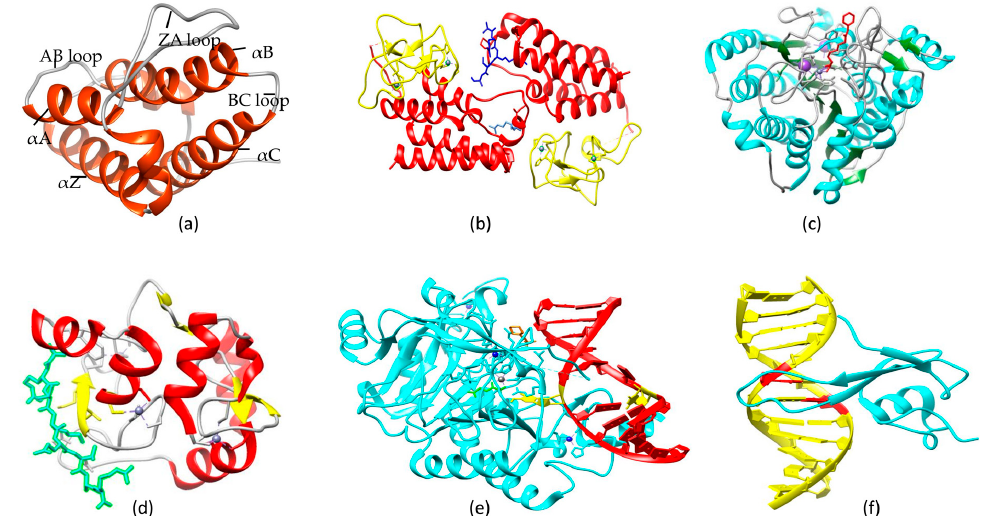
Figure 4. Structure and complexes of epigenetic proteins. ( a ) Structure of SP100 (Speckled 100 kDa): the hydrophobic cavity formed by helices can accommodate histone sequences (PDB ID: 4PTB) (orange = helices, gray = loops); ( b ) Crystal structure of TRIM24 PHD-BRD complexed with H3K27 acetylated peptide (PDB ID: 3O35) (yellow = PHD, red = bromodomain, blue = H3K4ac, cornflower blue = H3K27ac, dark gray = zinc (II) ions ( c ) Crystal structure of HDAC-like protein (Chain A) bound to SAHA (PDB ID: 1ZZ1) (red = SAHA, dark gray ball = Zinc, purple ball = potassium); ( d ) Crystal structure of DNMT3A ADD domain (Chain C) bound to H3 peptide (PDB ID: 4QBQ) (cyan = H3 peptide, dark grey = zinc); ( e ) Crystal structure of TET2 protein in complex with 5hmC (PDB ID: 5DEU) (cyan = TET2, red = DNA, yellow = 2 ′ -deoxy-5-(hydroxymethyl) cytidine 5 ′ -(dihydrogen phosphate), dim gray ball = Fe (III) ion, orange = 2-( n -morpholino)-ethanesulfonic acid, green = n -oxalylglycine, blue = zinc (II) ion ( f ) Solution structure of the methylated CpG binding domain of human MBD1in complex with methylated DNA (PDB ID: 1IG4) (cyan = binding domain of MBD1, yellow = DNA, red = methylated cytosine).